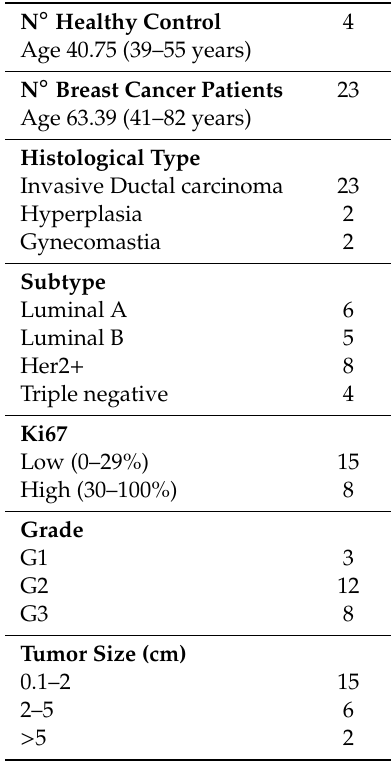
Table 4. Clinicopathological characteristics of the study